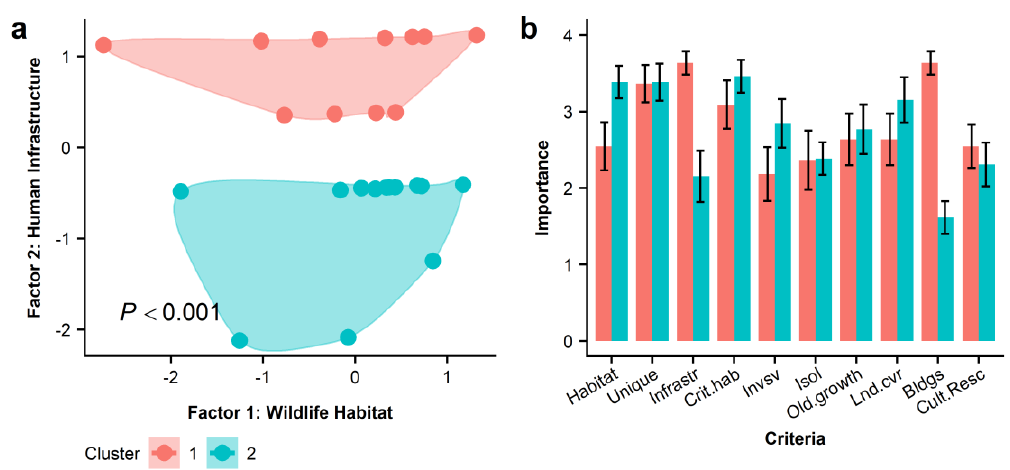
Figure 3. Plots of the respondents’ factor scores grouped by ( a ) ecosystem type, ( b ) occupational category, ( c ) refugia species of concern, ( d ) agency, and ( e ) management type. Polygons were plotted to encircle all points within each group. Agencies are: US Forest Service (USFS), US Bureau of Land Management (BLM), Washington Department of Fish and Wildlife (DFW), National Park Service (NPS), Oregon Department of Fish and Wildlife (ODFW), and all others (NON). Occupations are “ Fire mgr. ” (fire manager) , “Land mg r .” (land manager), “ O ther (ag.)” (other agency positions), and “ Other (non ag.)” (other non -agency positions). p -values are from MANOVA tests, which test for differences between groups by respondent ’ s scores.